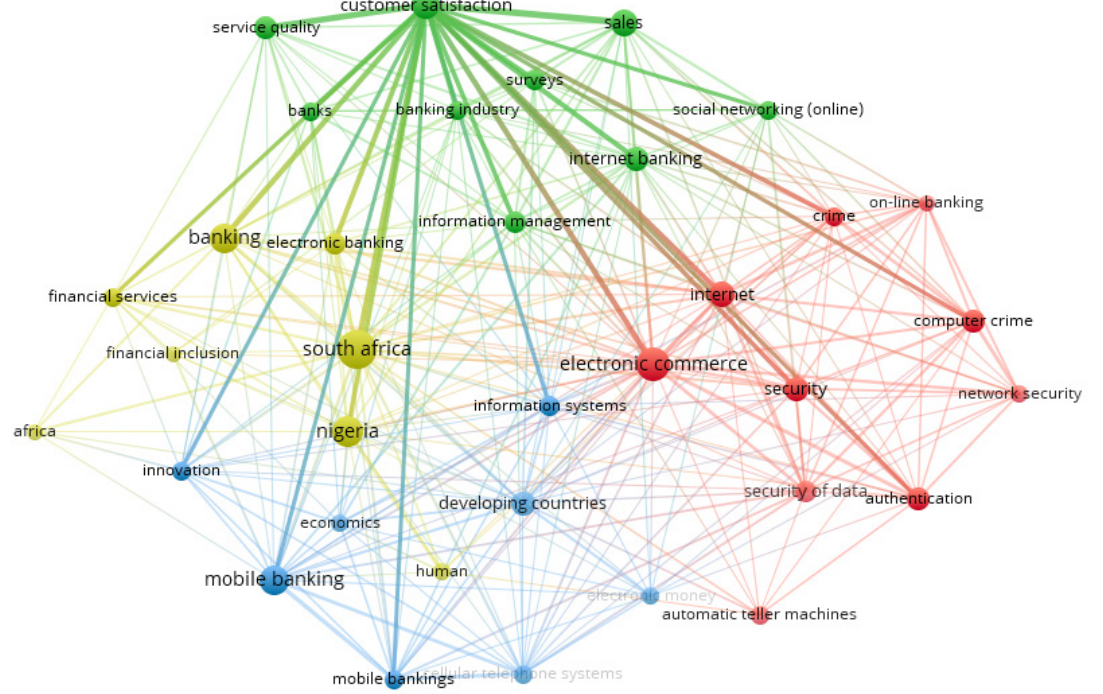
Figure 4. Top 35 keyword co-occurrences (Scopus